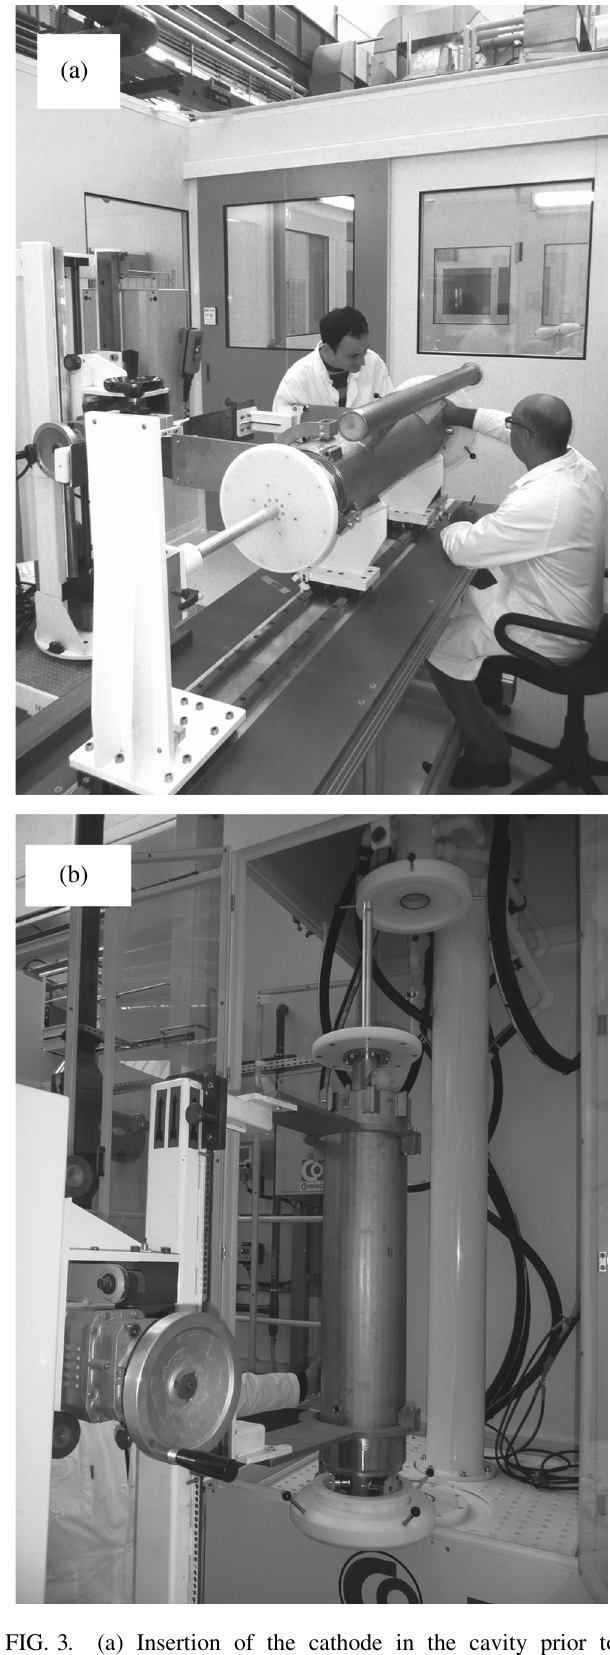
FIG. 2. Flowsheet of the process displayed on the touchscreen.